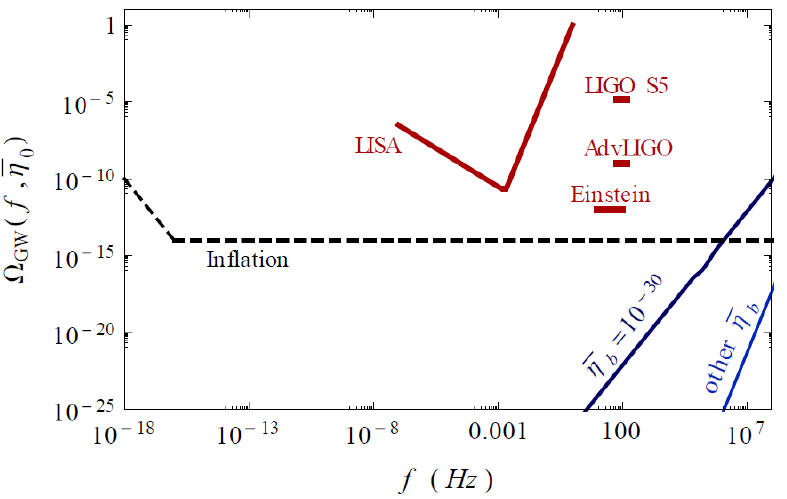
Figure 3. The figure shows a comparison of our results, labeled by ¯ η b (the smaller this parameter, the bigger the energy scale of the bounce, and the value 10 − 30 is only two orders of magnitude away from the Planck scale) with experimental sensitivities of LIGO’s 5th run, Advanced LIGO, and the forthcoming LISA and Einstein Telescope, and a prediction of the upper limits on the spectrum of primordial gravitational waves generated in inflationary